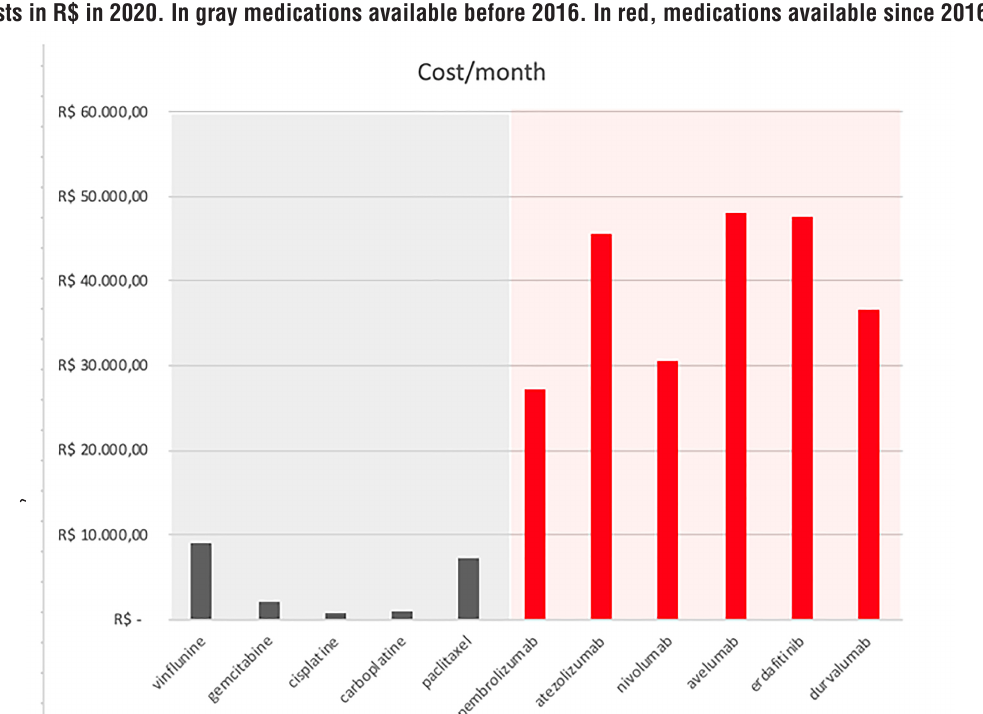
Font: Site https://consultaremedios.com.br. Estimated values for a 70Kg